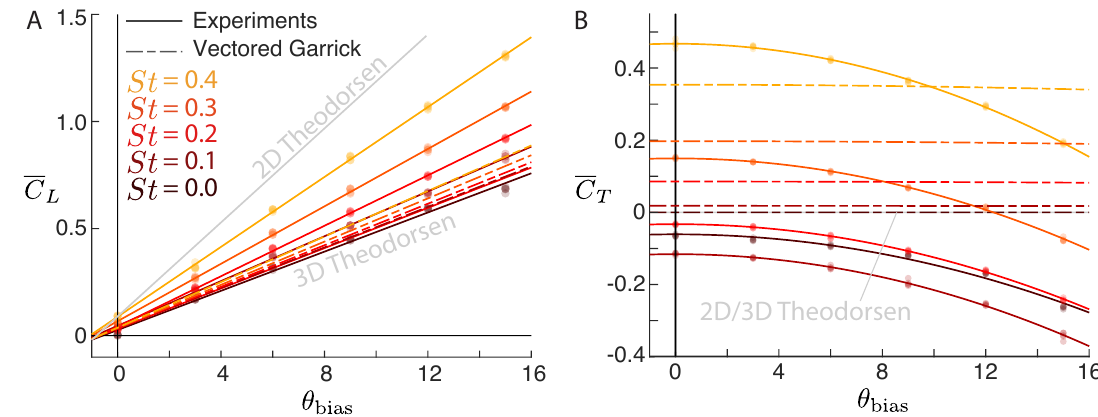
Figure 2. Lateral and streamwise forces deviate from linear theory at high Strouhal numbers and pitch bias angles. ( A ) The time-averaged force perpendicular to the incoming flow (lift) increases linearly with pitch bias ( θ bias ) with a slope that increases with Strouhal number. Colored circles show experimental data; solid lines show linear fits (average R 2 = 0.998). The Vectored Garrick model (dashed lines; Section 4.3) predicts the linear trend but underpredicts the slope. At St = 0, the experimental data, the Vectored Garrick model, and the 3D Theodorsen model overlap and so cannot be distinguished on the plot. ( B ) The time-averaged force parallel to the incoming flow (thrust) decreases with pitch bias. Colored circles show experimental data; solid lines show quadratic fits (average R 2 = 0.994). The inviscid Garrick model always predicts positive thrust and a small decrease with pitch bias of only 3% over 15 degrees of pitch bias. At St = 0, the Garrick model is equivalent to the 2D and 3D Theodorsen model.